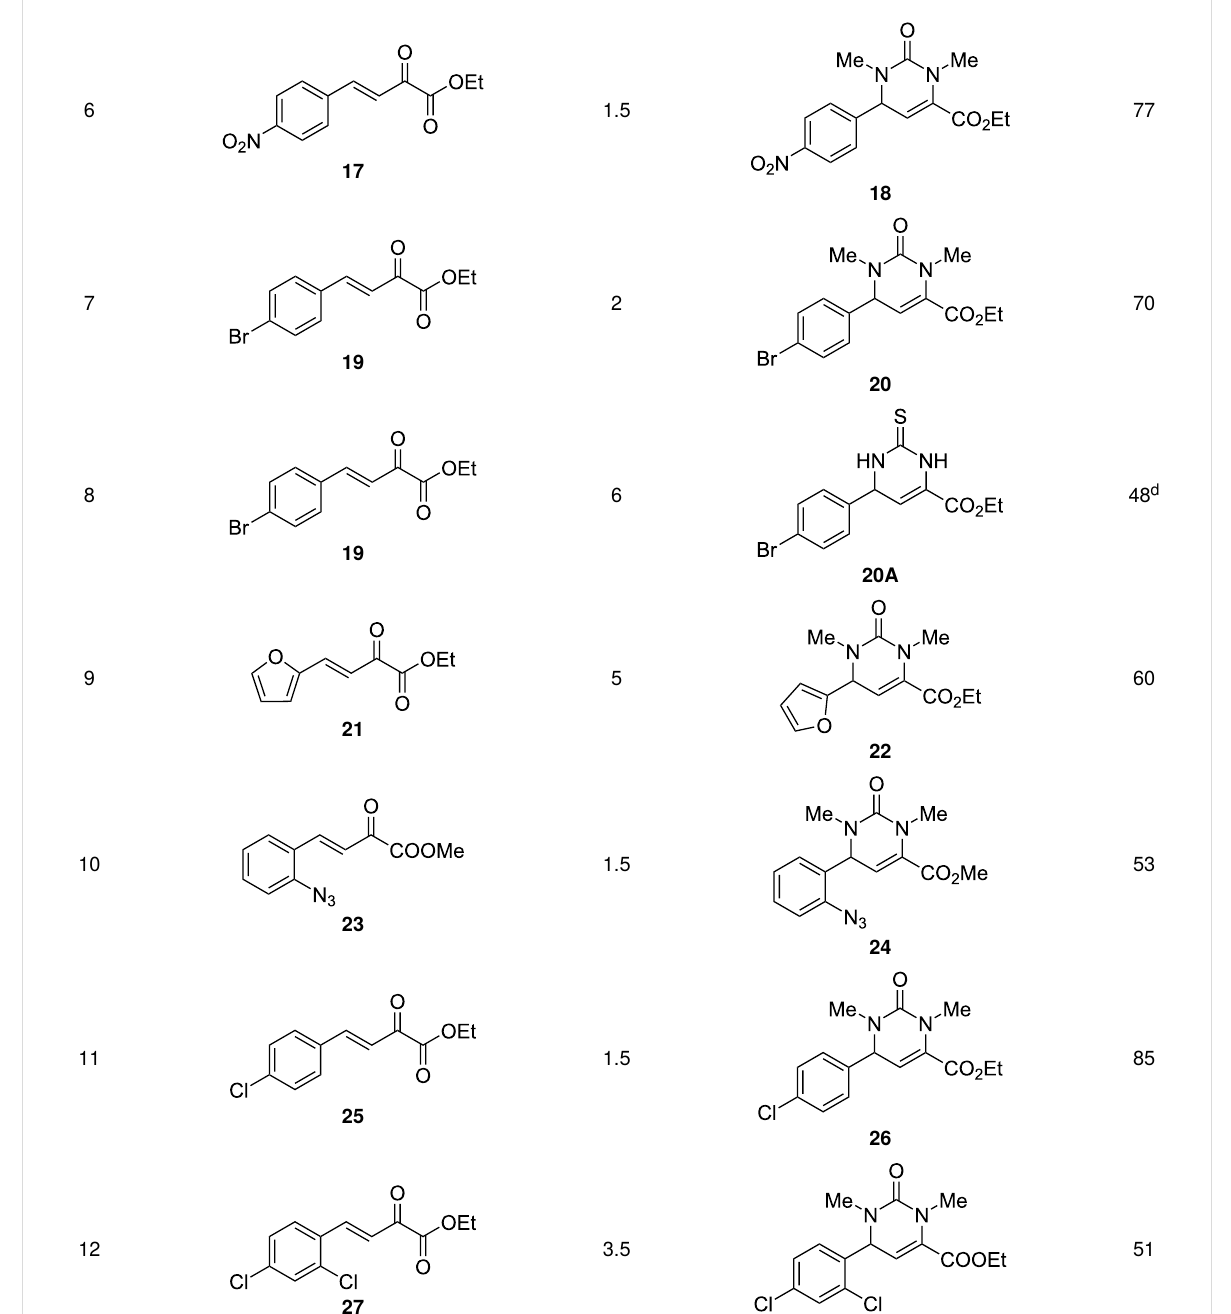
Table 1: Synthesis of 5-unsubstituted DHPMs. a